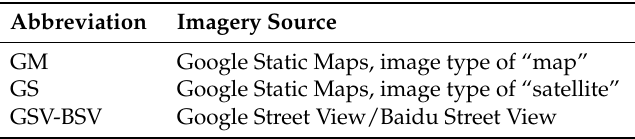
Table 1. Neural networks trained and evaluated in this study.